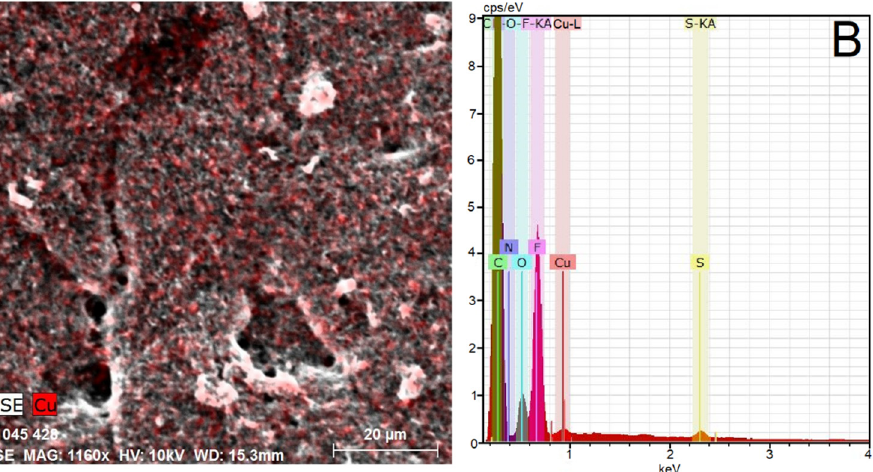
Figure 2. ( B ) Elemental mapping of MWCNTs layers covered by Nafion ® membrane containing the